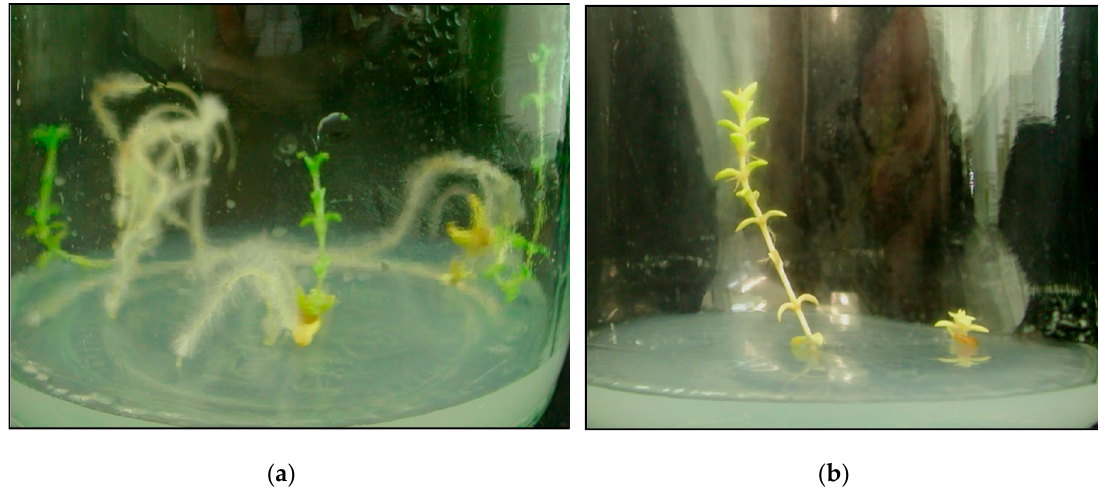
Figure 7. Rooting stage (6 weeks of growth). Top explants rooted on the medium with the addition of 1.5 mg · dm − 3 NAA ( a ). Top (left) and shoot (right) explants rooted on the medium with the addition of 1 mg · dm − 3 NAA ( b ). Table 3. E ff ects of type of explant on the multiplication of Honckenya peploides propagated on MS media with the addition of 1.5 mg · dm − 3 NAA and varied NaCl